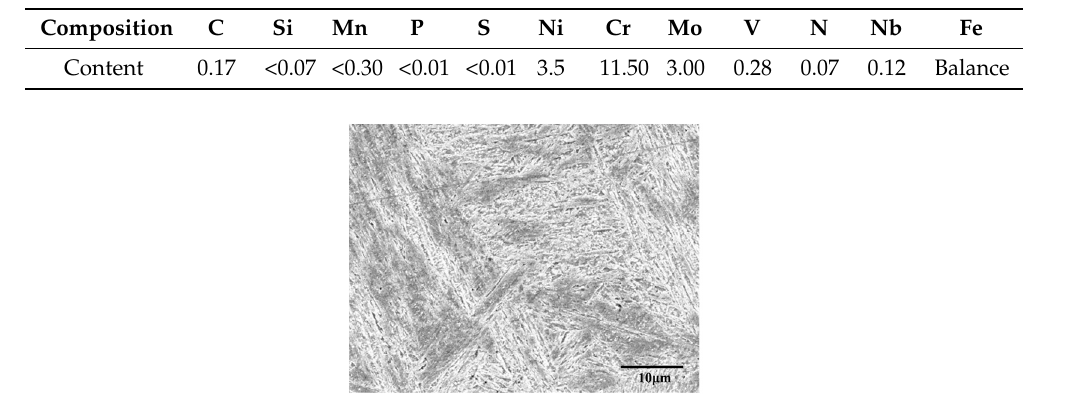
Figure 1. The microstructure of the sample material (SEM).